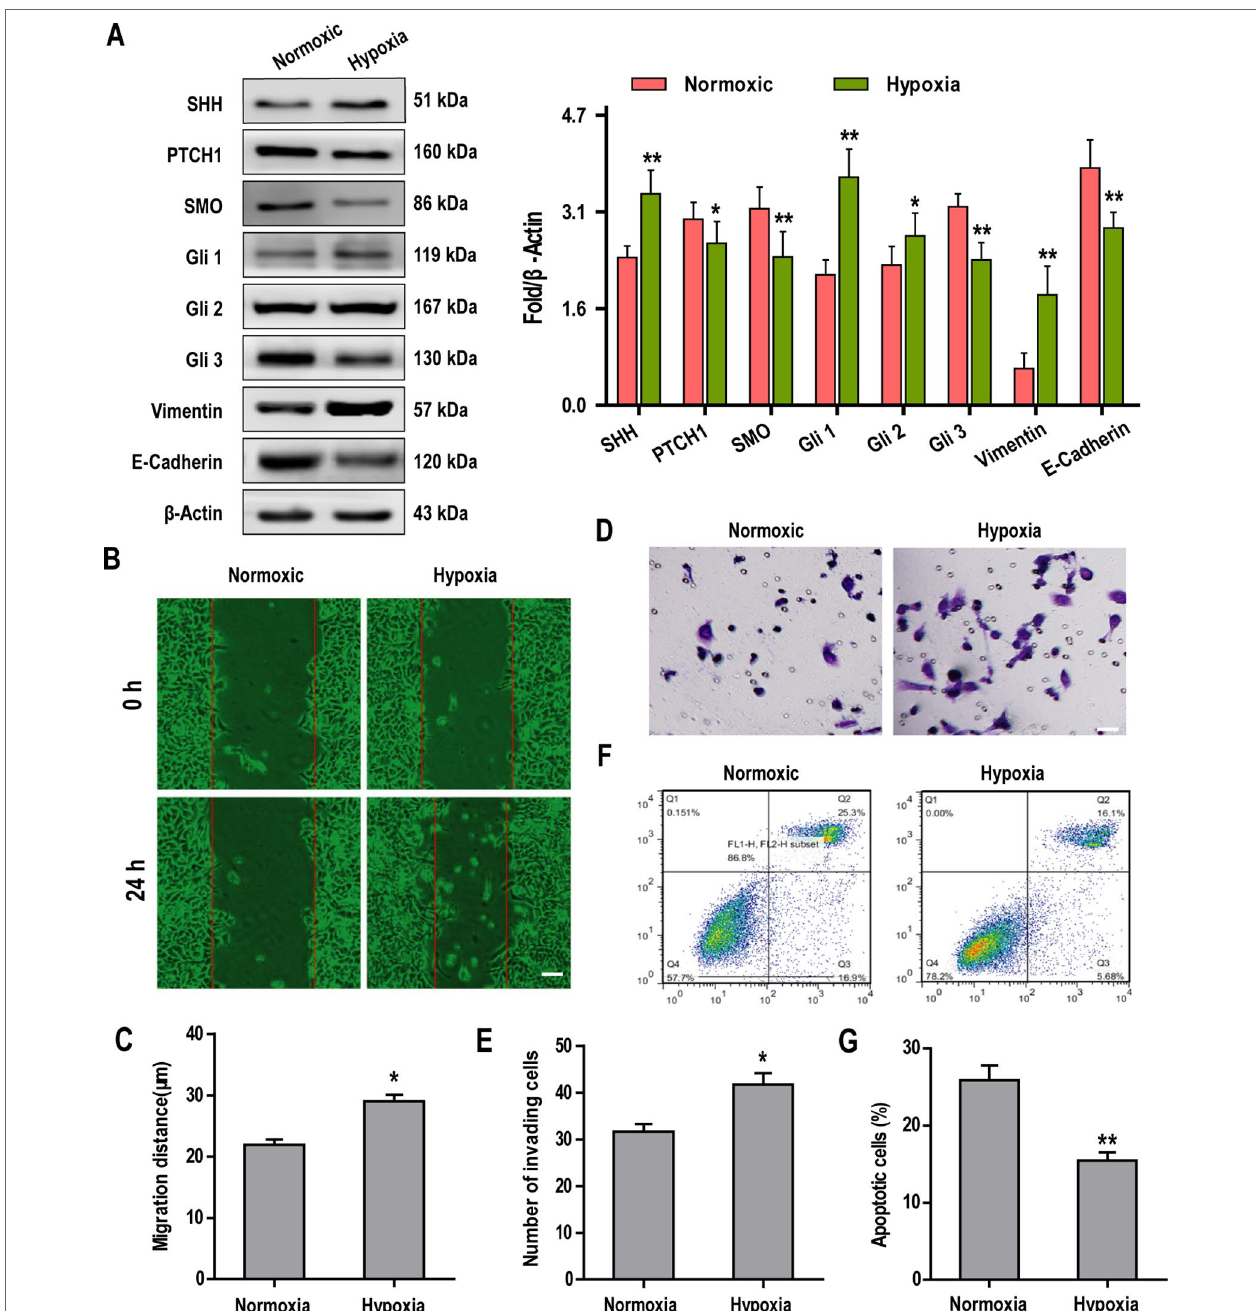
hypoxic conditions was analyzed over 24 h using a wound healing assay (scale bar, 50 µ m). (D , E) Hep3B cell invasion was examined by transwell assay (scale bar,